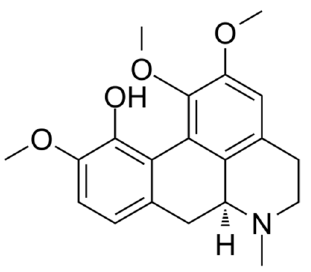
Figure 1. Chemical structure of